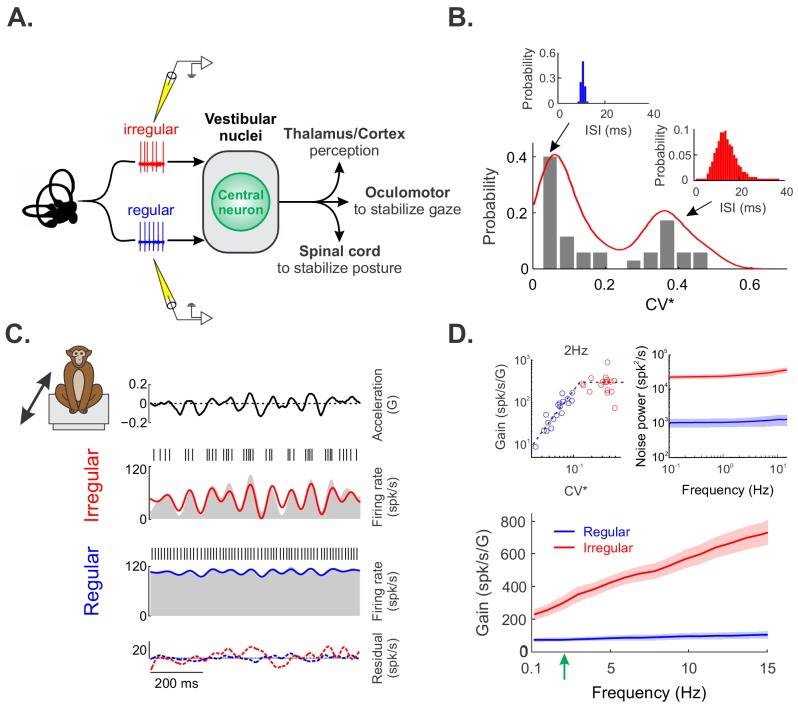
Regular and irregular otolith afferent responses to naturalistic translational self-motion stimuli.(A) Schematic showing early vestibular pathways and recording sites. (B) Distribution of resting discharge variability as quantified by CV* for our dataset. As detailed in the Materials and methods, CV* is a normalized coefficient of variation that is used to quantify resting discharge variability independently of differences in firing rate (Goldberg et al., 1984). The distribution was clearly bimodal (Hartigan’s dip test, p=0.04). The insets show the interspike interval histograms from example regular (left, blue) and irregular (right, red) afferents with CV*=0.06 and 0.29, respectively. (C) Time varying linear head acceleration (top row) with corresponding spiking and firing rate from example irregular (second row from top) and regular (third row from top) afferents. The linear firing rate predictions for the irregular and regular afferents are shown in red and blue, respectively. The time varying residuals (i.e., difference between the actual and predicted responses) are also shown for each afferent (bottom row). (D) Population-averaged gains for regular (blue, N = 18) and irregular (red, N = 17) afferents as a function of stimulus frequency. Top left inset: Gain at 2 Hz (green arrow in bottom panel) as a function of CV*. Top right inset: Population-averaged power spectra of the residual for regular (blue) and irregular (red) afferents. The shaded bands show 1 SEM.